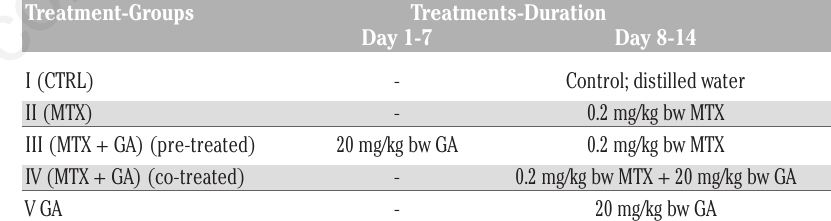
Table 1. Experimental design.